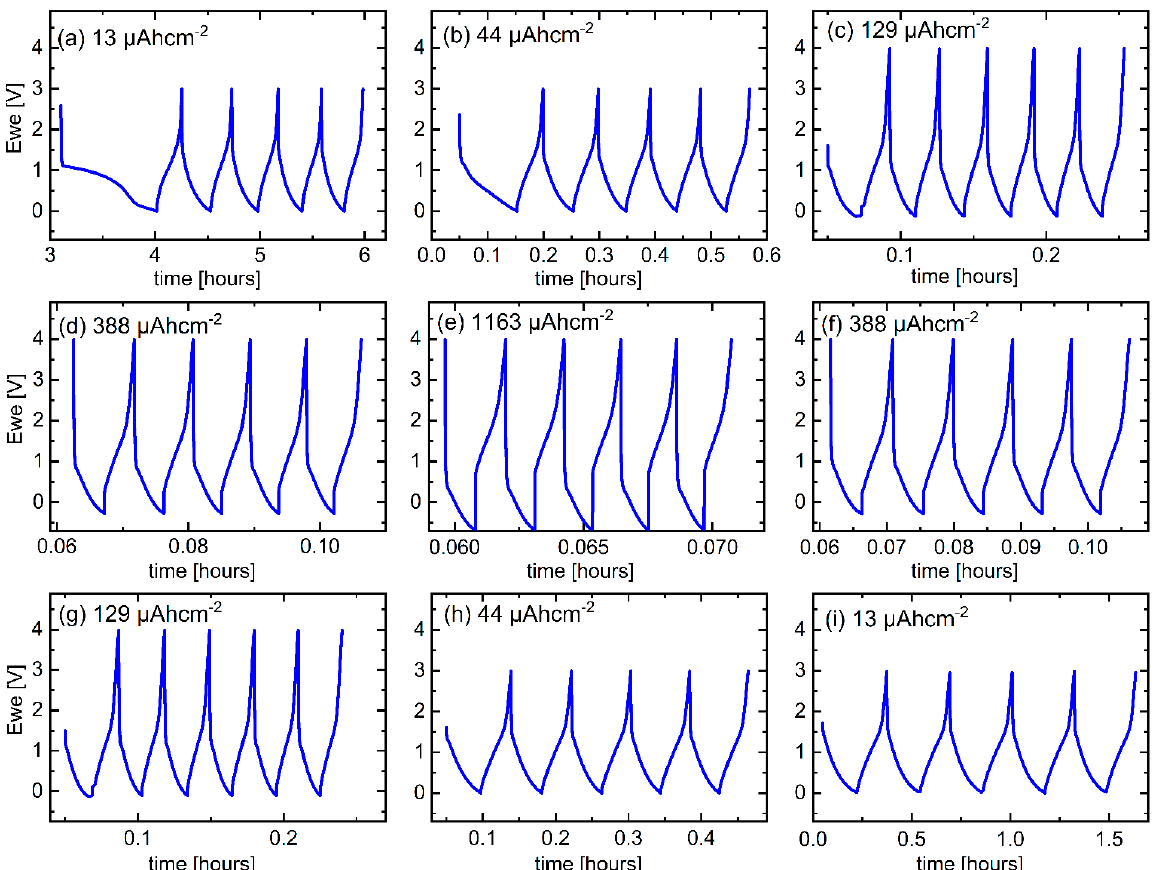
Figure 6. CC potential profiles measured during the rate capability experiment for the C/Cu ML for ( a – e ) ascending current densities and ( f – i ) descending current densities after each pack of five cycles. A color version of this figure can be viewed online.